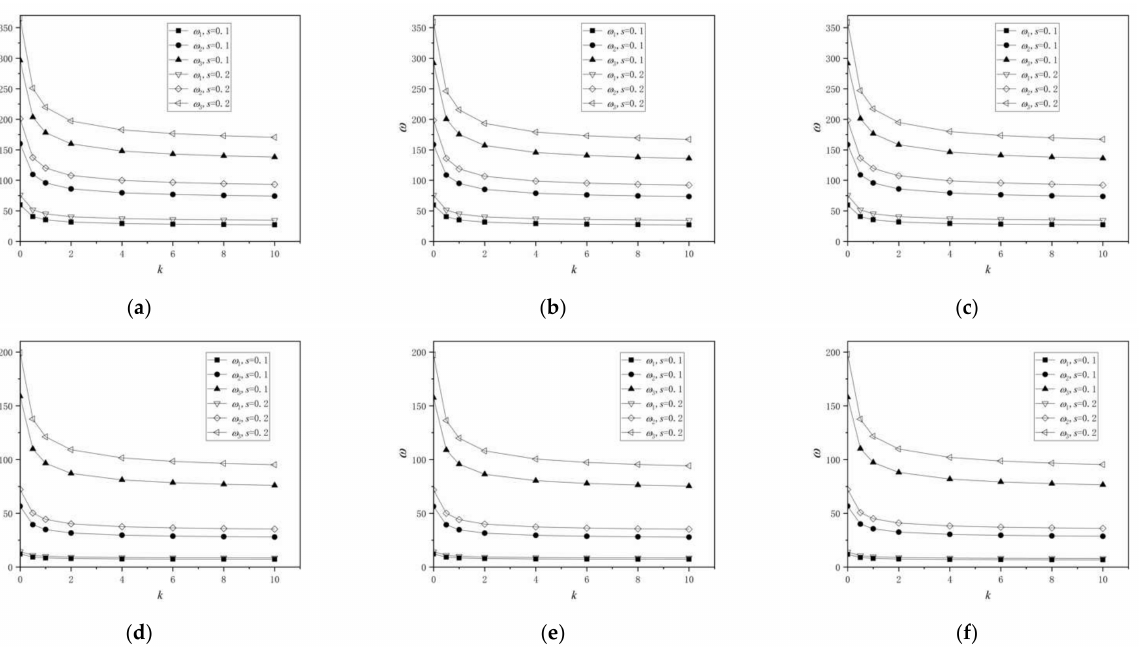
Figure 4. The relationship between dimensionless natural frequencies and the functionally gradient index under two different boundary conditions. ( a ) C-C Kirchhoff plate; ( b ) C-C Mindlin plate;